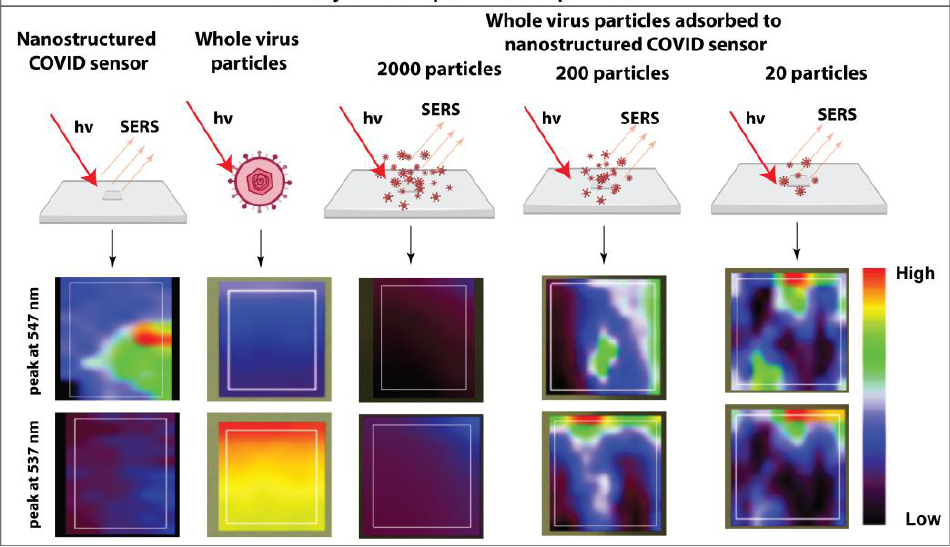
Figure 4. Mechanism of signal enhancement in the label-free SERS assay demonstrated through the fluorescence quenching on adsorption of whole virus particles on the nanostructured sensor.